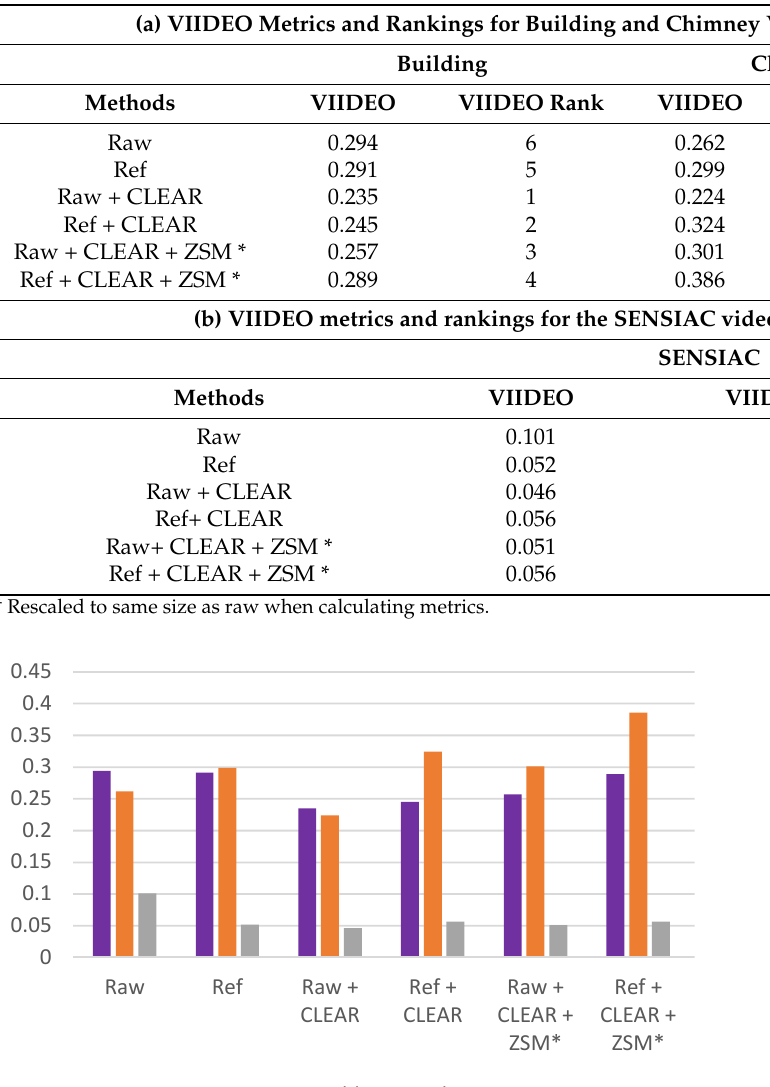
(b) VIIDEO metrics and rankings for the SENSIAC video